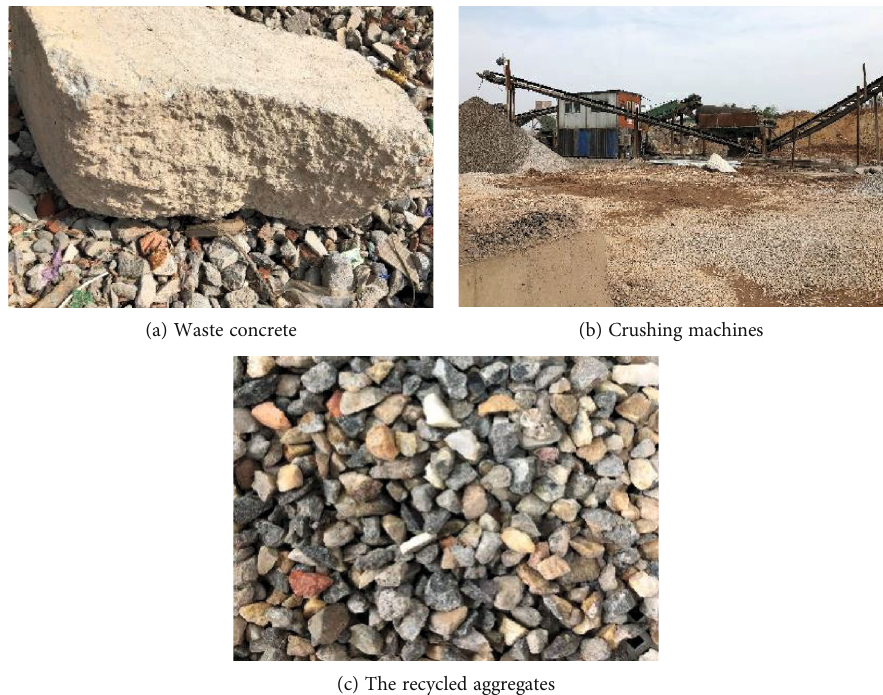
Figure 2: The recycled concrete aggregates used in the